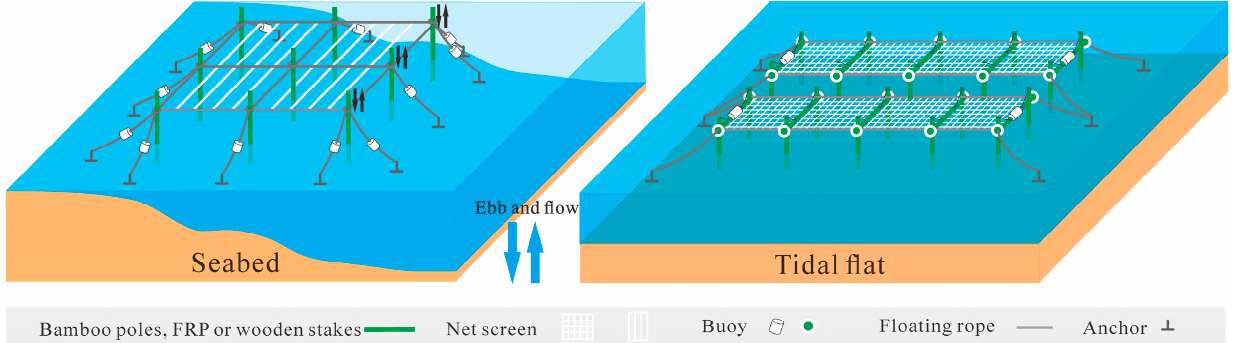
Figure 8. Diagram of different types of seaweed rafts (Stay-pole raft aquaculture in the shallow sea ( Left ), Semi-floating raft in the intertidal zone ( Right )).